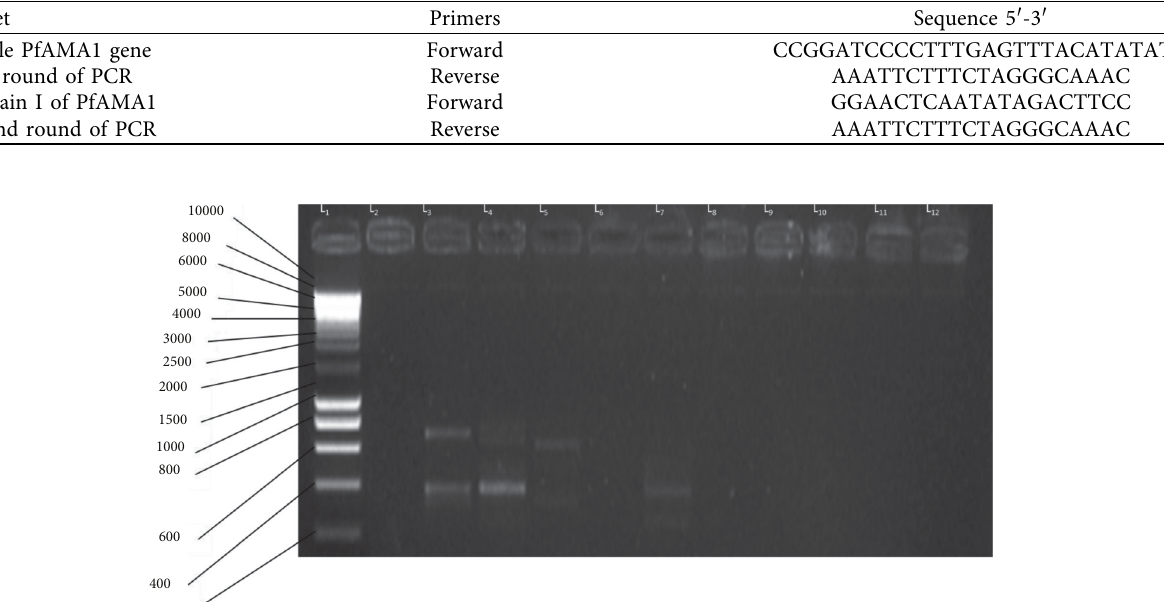
Figure 1: Exemplary gel showing AMA1 fragments produced after the second round of PCR (created by the authors of this work). L molecular weight marker (10,000bp); L 3 : variants with 700bp and 400bp; L 4 : variant with 400bp; L 5 : variant with 700bp; L 7 : variant with 400bp; L 12 : negative